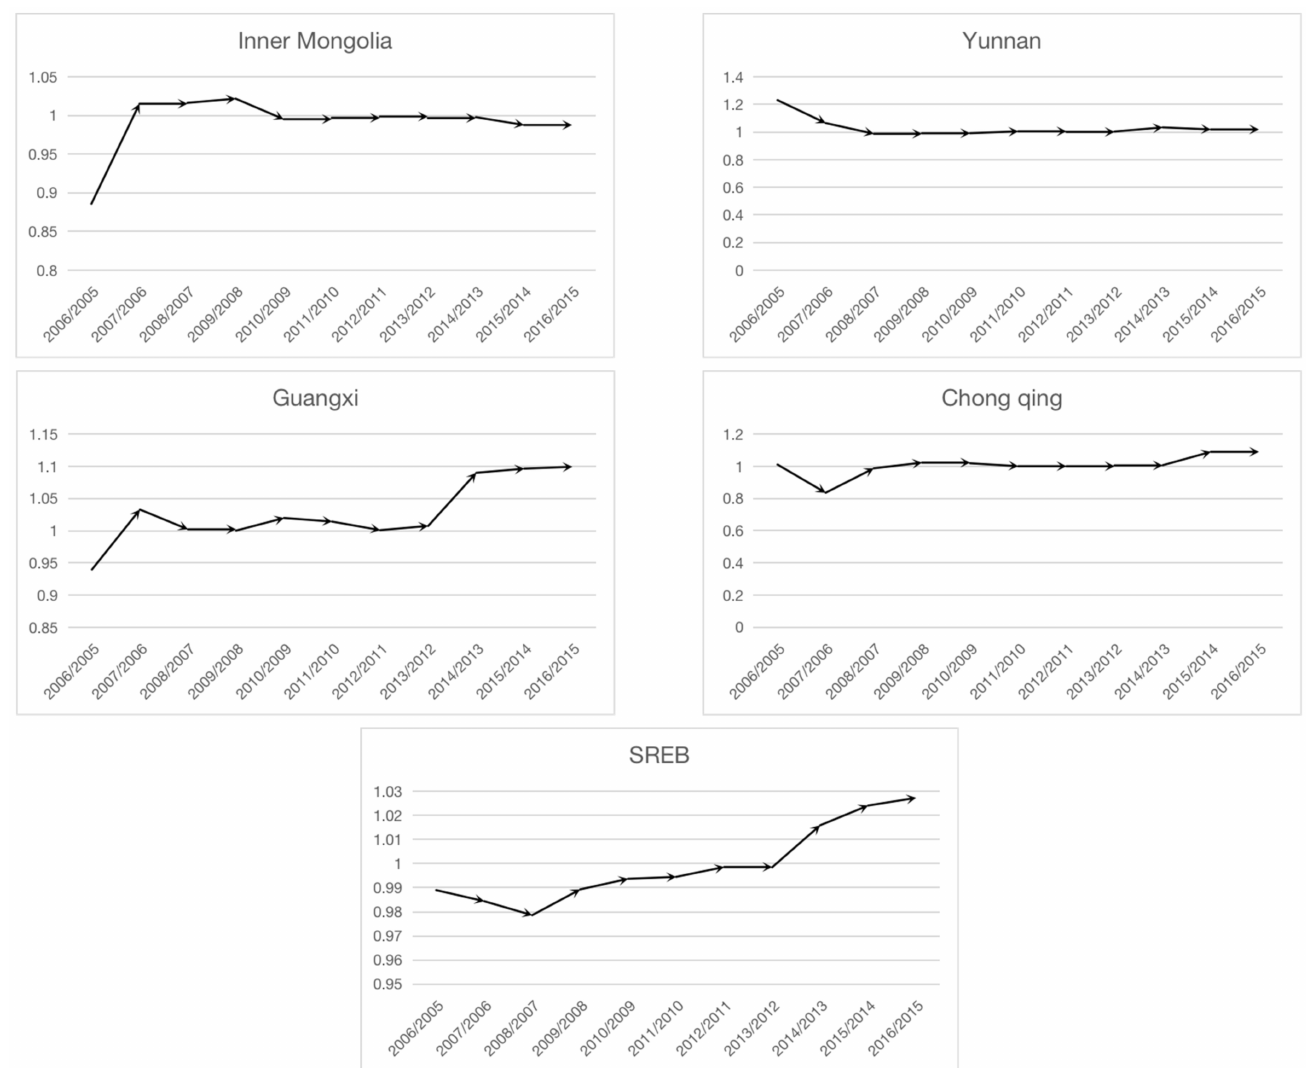
Figure 5. Technical-efficiency performance by